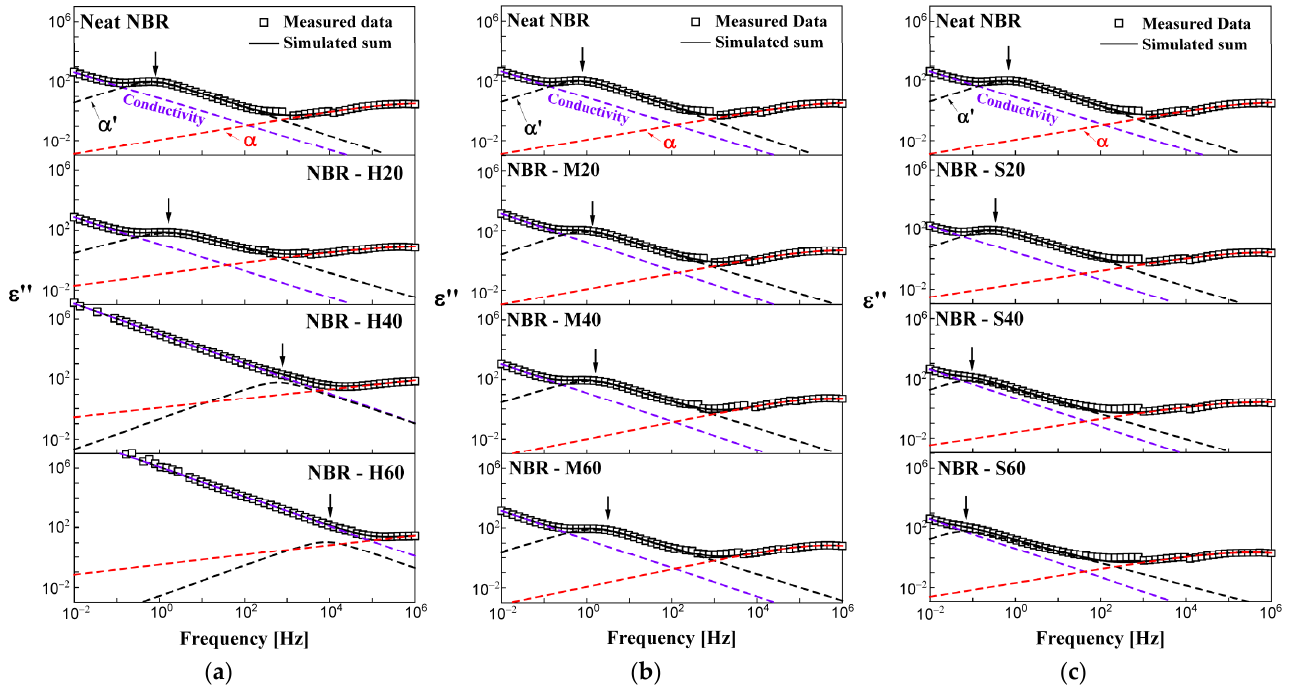
Figure 2. Influence of filler loading on the dielectric loss spectra in the frequency range from 0.01 Hz to 1 MHz for neat NBR and ( a ) NBR-H series, ( b ) M series, and ( c ) S series at 298 K. To compare neat NBR and NBRs with filler, we show here three identical neat NBR loss spectra on the top side of each figure ( a – c ). The arrows indicate the central frequency for the α′ process.